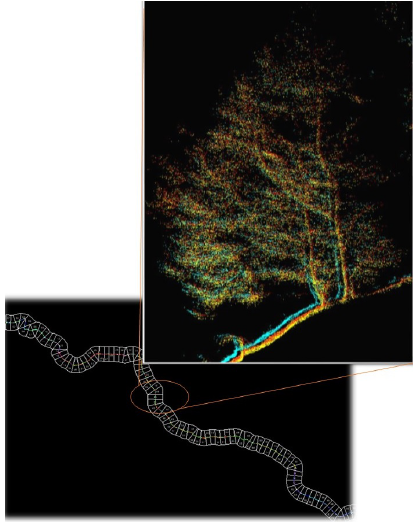
Figure 3: Example of point cloud mismatch